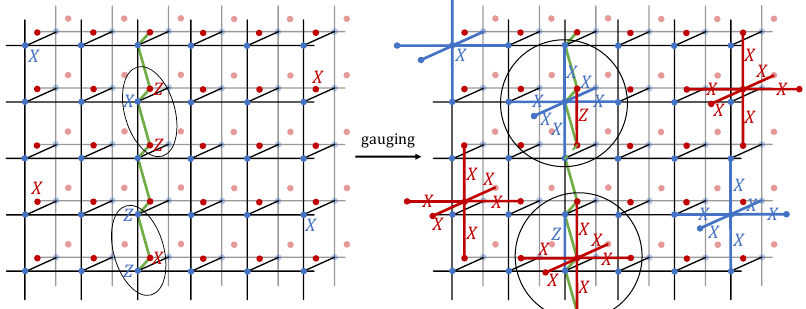
Figure 13: Left: each blue or red dot represents a qubit. The cluster state is decorated on the green line, which makes the Hamiltonian have Pauli X coupled to adjacent Pauli Z ; otherwise, each dot gives Pauli X to the Hamiltonian. Right: after gauging (cid:90) × (cid:90) symmetry, the singe Pauli X becomes the X -star term. On the green line, 2 2 the X -star term is dressed with an additional Z of a different color due to the cluster state